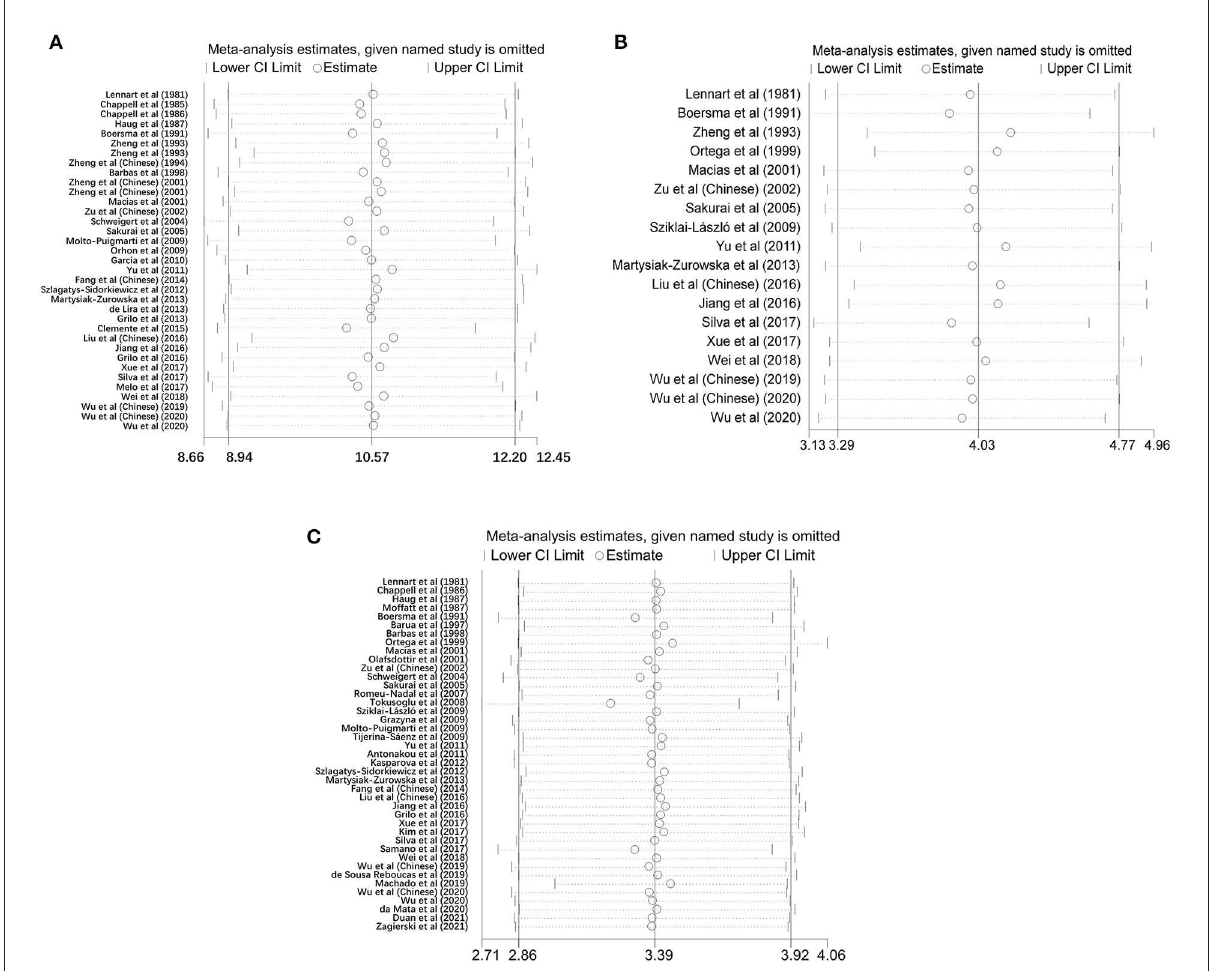
FIGURE4 Sensitivity analysis showed the influential studies on the overall pooled effect for colostrum (A) , transitional milk (B) and mature milk (C) .